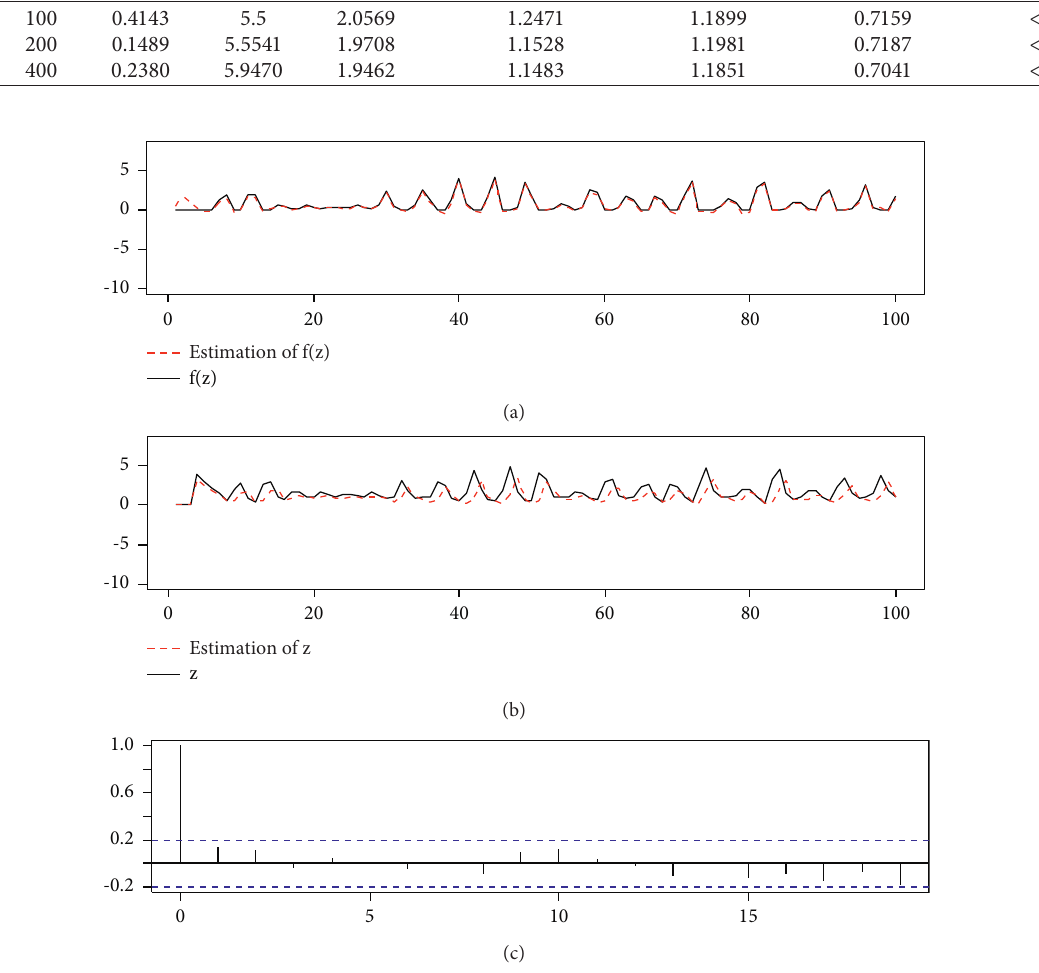
) . (b) Exact and estimated values of Z . (c) ACF of residuals, h t